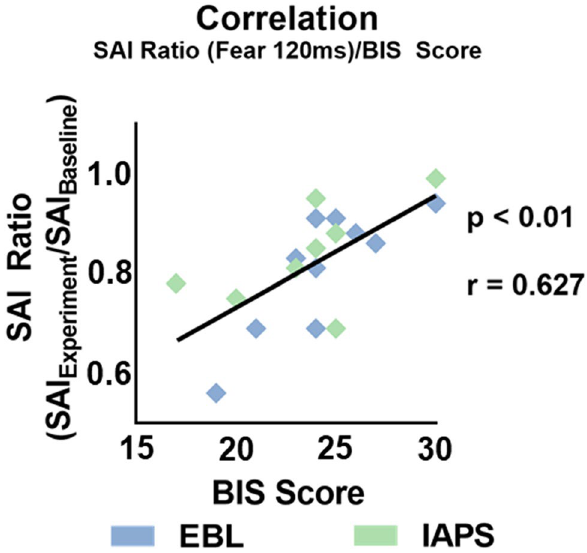
Figure 4. Correlation analysis on SAI Ratio and BIS. Pearson correlation analysis for SAI Ratio computed for fearful stimuli at 120 ms after stimulus onset and BIS scores of participants from both EBL and IAPS. A positive correlation is observable between the two sets of data, meaning that at a higher BIS score corresponded a decreased SAI and vice versa.